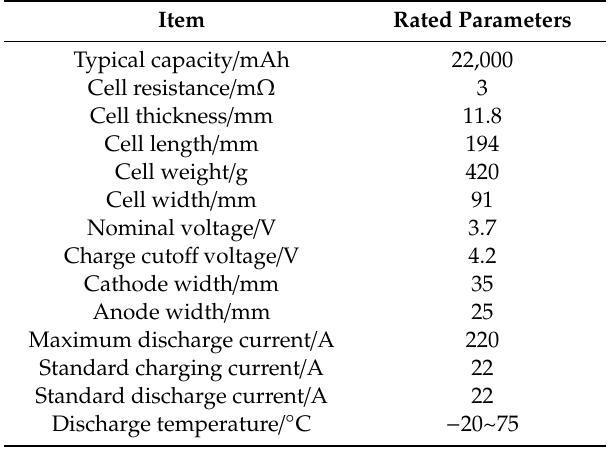
Table 1. Physical parameters of a lithium iron phosphate polymer lithium ion single